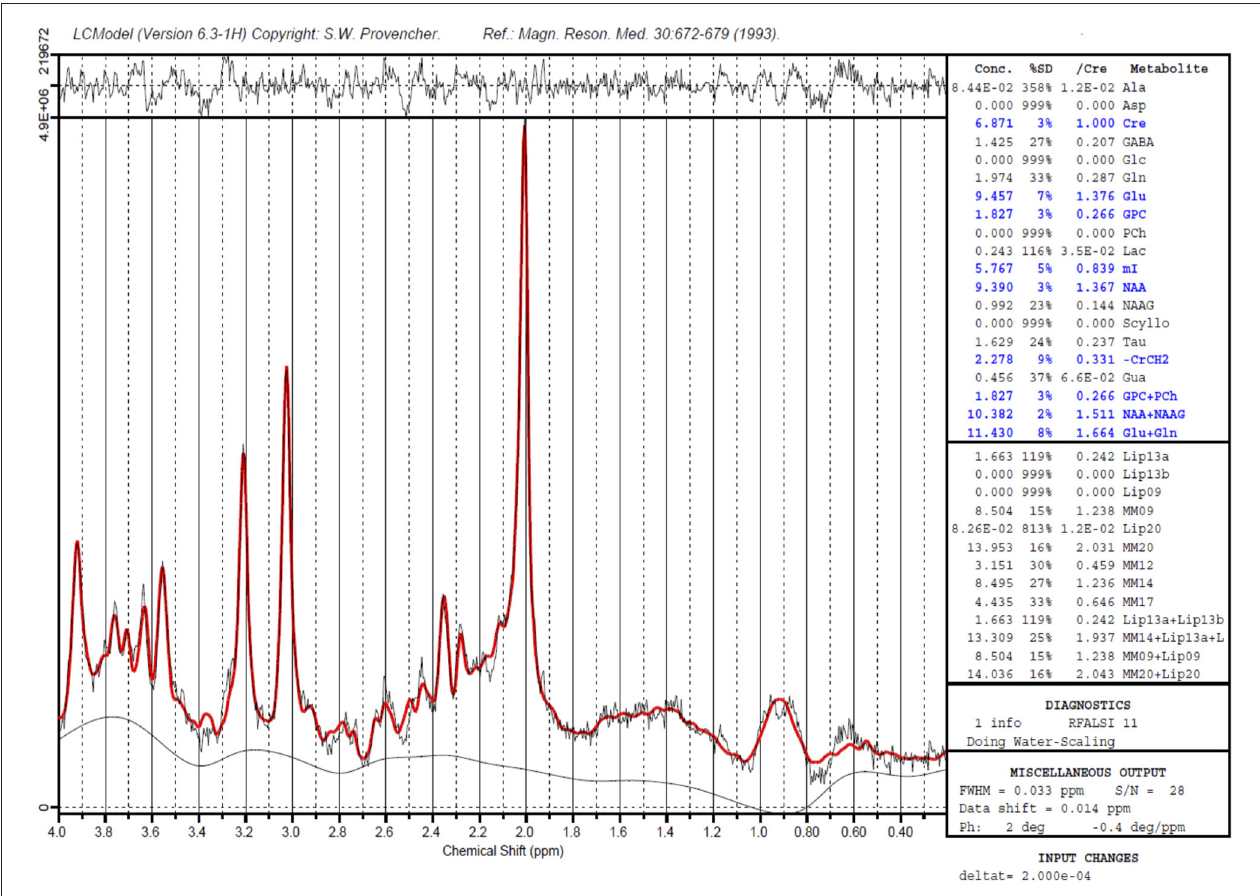
FIGURE 1 | A sample H 1 - MRS spectrum, created with the LCModel software. Peaks of Creatine (two peaks), myo-Inositol, Choline and N-acyl aspartate are marked. The chemical shift (ppm) is shown on the X-axis. The Y- axis shows the intensity of the signal (measured in institutional units). The area under the curve is proportional with the concentration of the metabolite. For GABA, a special technique is